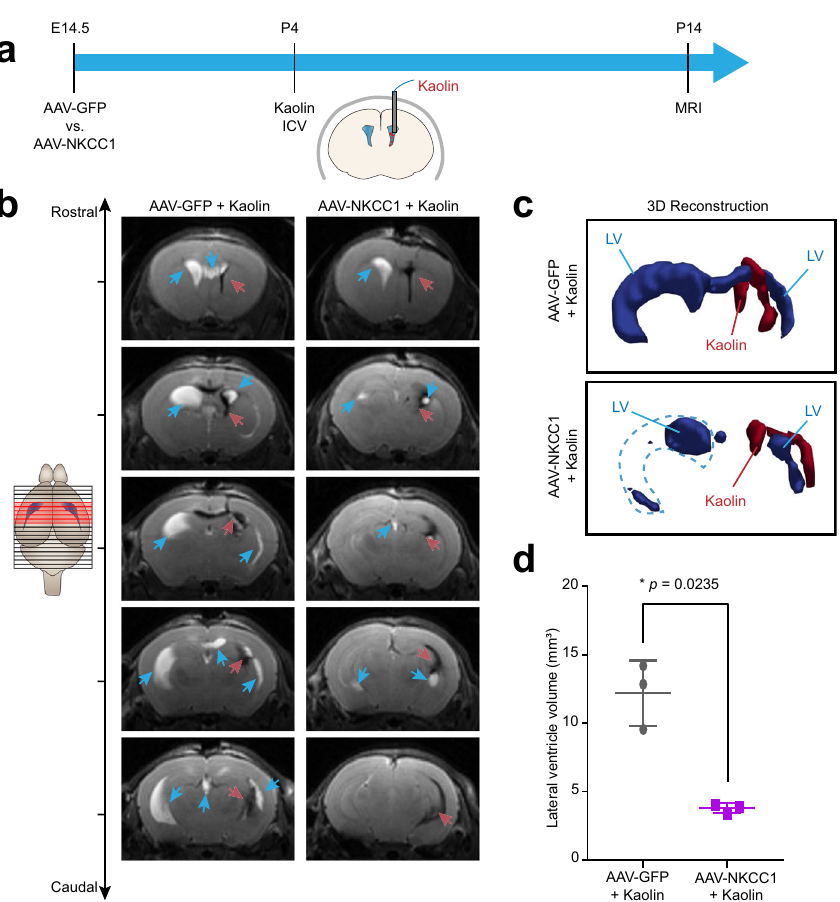
Fig. 6 ChP NKCC1 overexpression mitigates ventriculomegaly in an obstructive hydrocephalus model. a Schematics showing the work fl ow: E14.5 in utero ICV of AAV2/5-NKCC1 or AAV2/5-GFP, followed by ICV of kaolin at P4, and MRI at P14. b Representative sequential brain images (rostral to caudal) by T2-weighted live MRI images. Blue arrows: Lateral ventricle (LV). Red arrows: kaolin. c 3D reconstruction of the LV and kaolin deposition. LV: blue. Kaolin: red. d Lateral ventricle volumes. N = 3 from two biologically independent litters under each condition; Gray: AAV-GFP mice with kaolin; purple: AAV-NKCC1 mice with kaolin. * p = 0.0.0235; Welch ’ s two-tailed unpaired t -test. All quantitative data are presented as mean ±